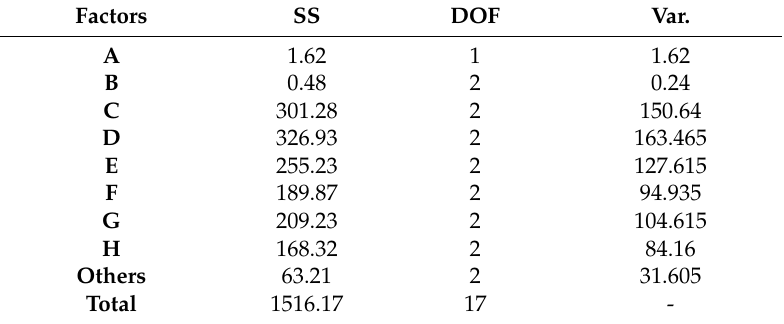
Table 5. Preliminary analysis of variance.